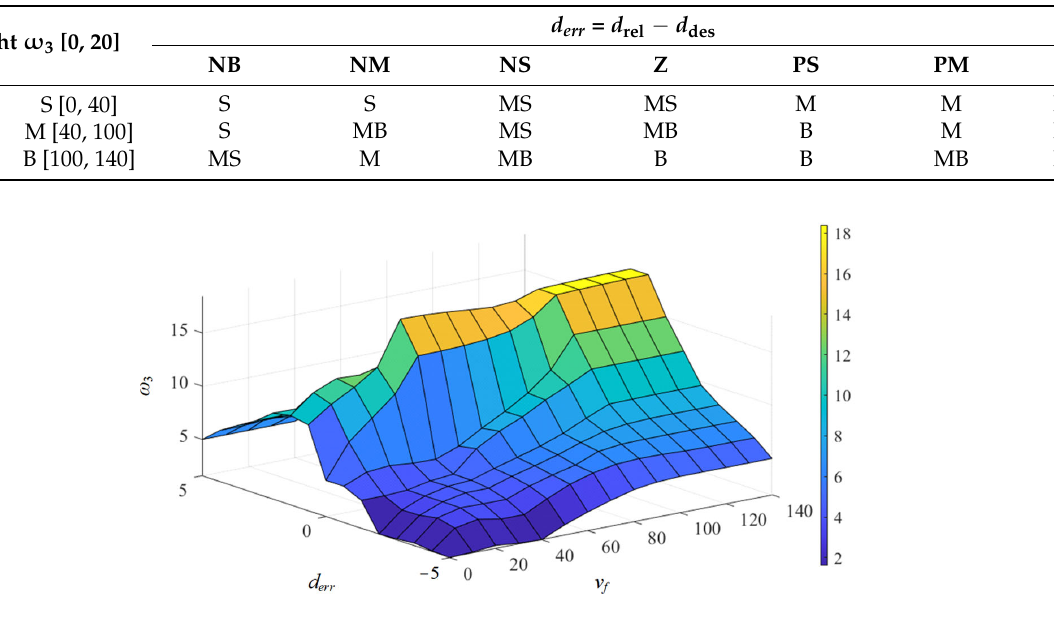
Figure 8. Relationship between distance error, v f and the economic weight coe ffi cient.